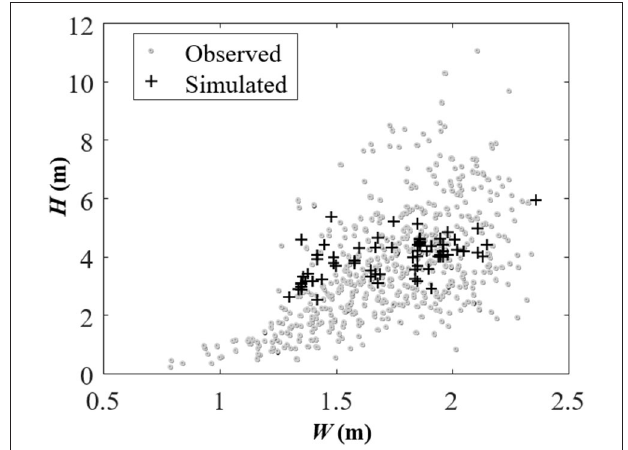
FIGURE 4 | Scatter plot of observed and simulated maximum wave height and peak water level based on the selected Clayton